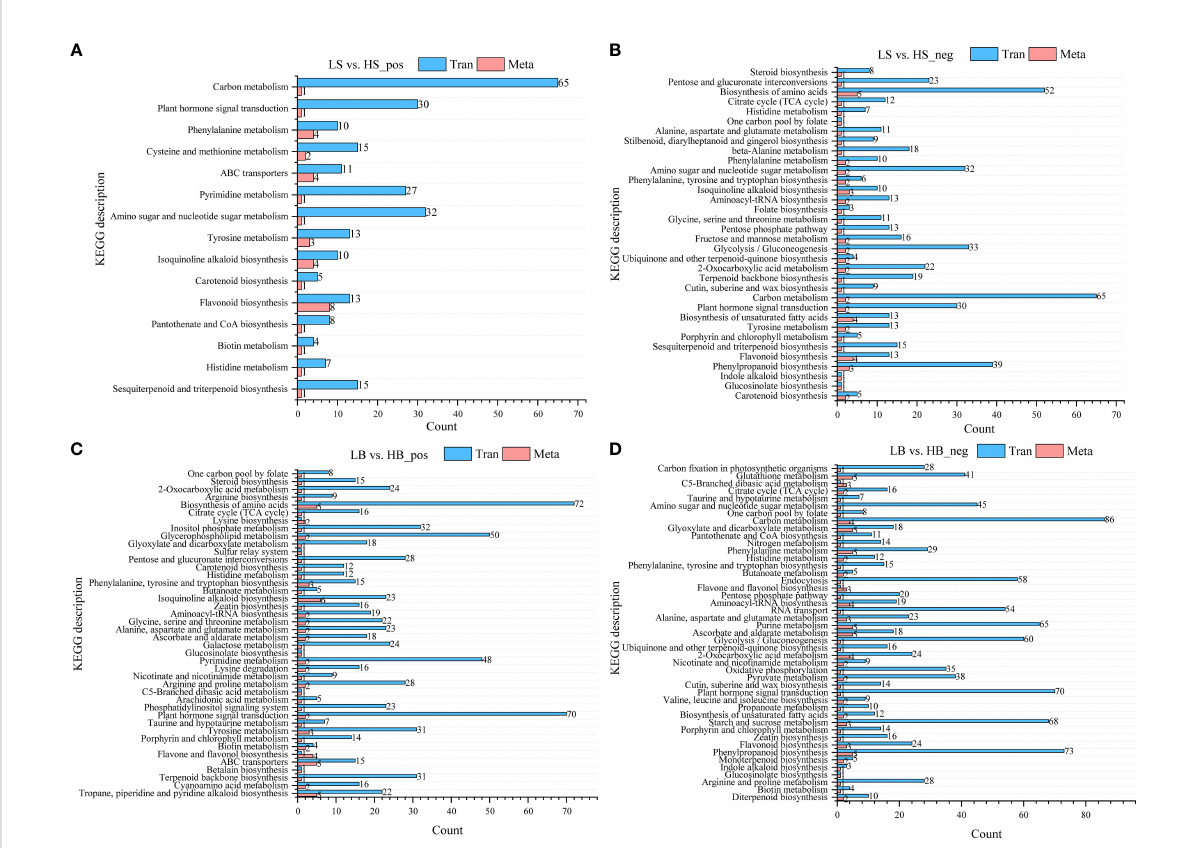
FIGURE 11 DEGs and DEMs KEGG enrichment pathways. (A) Pathway information of DEGs and DEMs of LS vs. HS in positive ion mode; (B) Pathway information of DEGs and DEMs of LS vs. HS in negative ion mode; (C) Pathway information of DEGs and DEMs of LB vs. HB in positive ion mode; (D) pathway information of DEGs and DEMs of LB vs. HB in negative ion mode. Tran: DEGs; Meta: